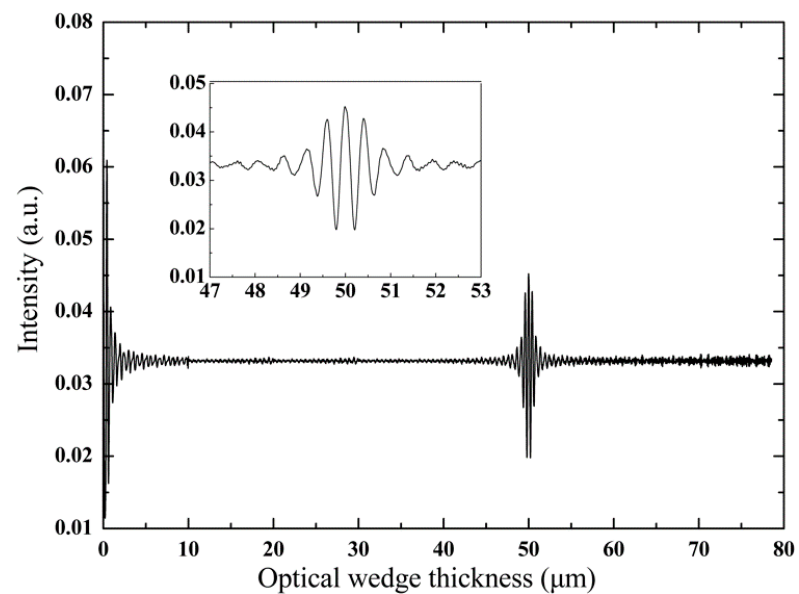
Figure 3. The relationship between the optical wedge thickness and the light intensity output.